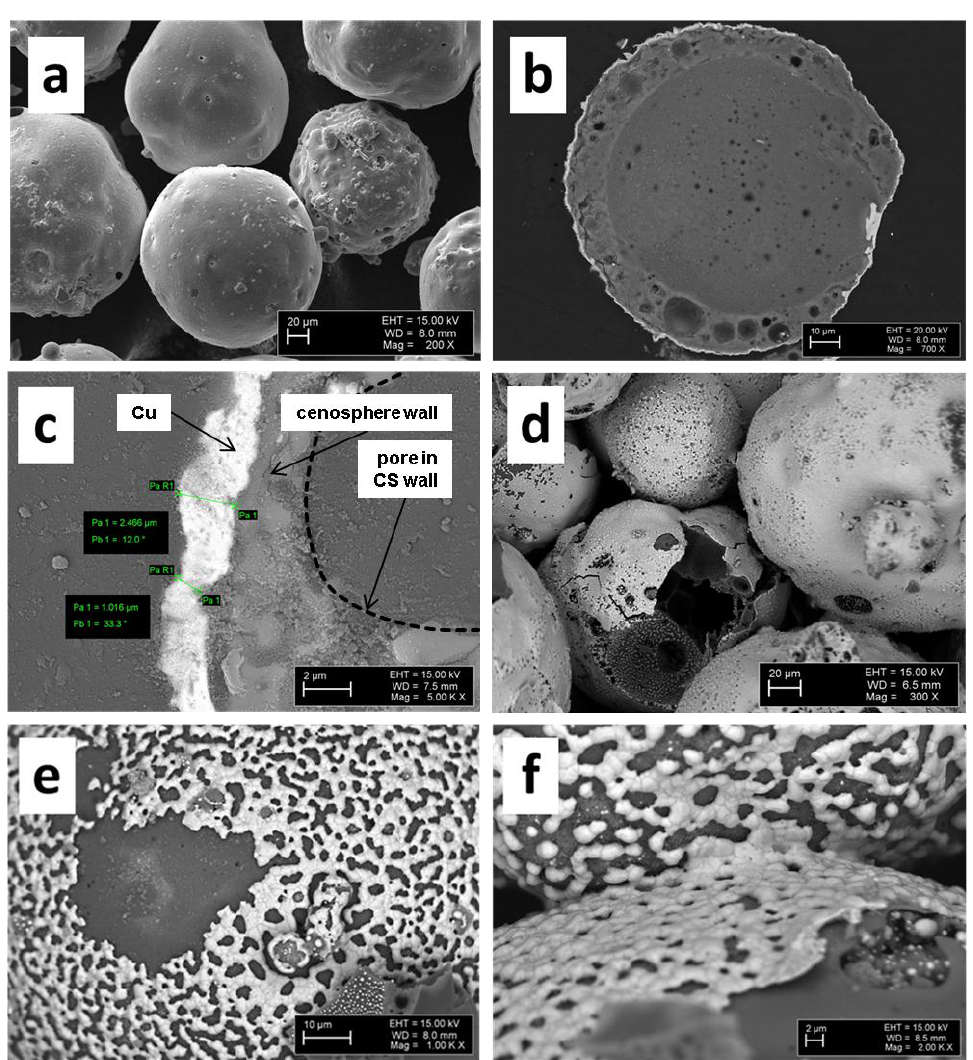
Figure 1. Various views of copper-coated cenospheres (Cu@CS materials, disc-shaped samples) before ( a – c ) and after sintering ( d – f ): ( a ) outward appearance; ( b ) cross section; ( c ) detail showing coating thickness; ( d ) sintered at 800 °C; ( e ) sintered at 900 °C; and ( f ) detail view showing inter-particle connection after sintering at 900 °C.